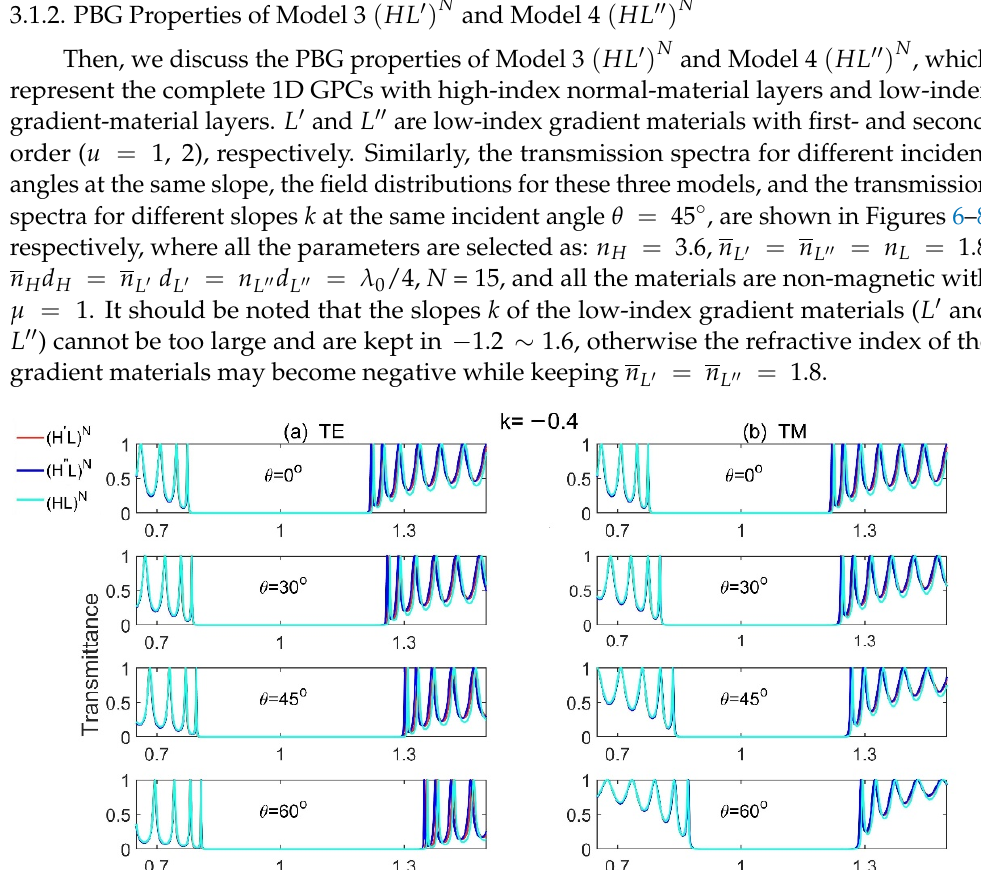
Figure 5. The relative bandwidth of PBG and omni-PBG for Model 1 (𝐻 (cid:4593) 𝐿) (cid:3015) , Model 2 (𝐻 (cid:4593)(cid:4593) 𝐿) (cid:3015) and the reference model (𝐻𝐿) (cid:3015) , ( a , b ) are relative bandwidth of PBG for different incident angles at 𝑘 = −10.4 , and ( c , d ) are relative bandwidth of omni-PBG for different slopes 𝑘 .